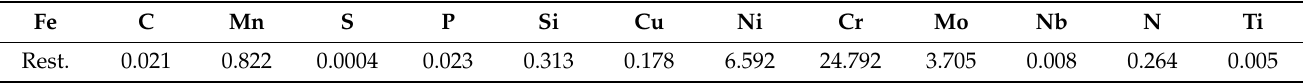
Table 1. Nominal chemical composition of the investigated AISI 2507 DSS